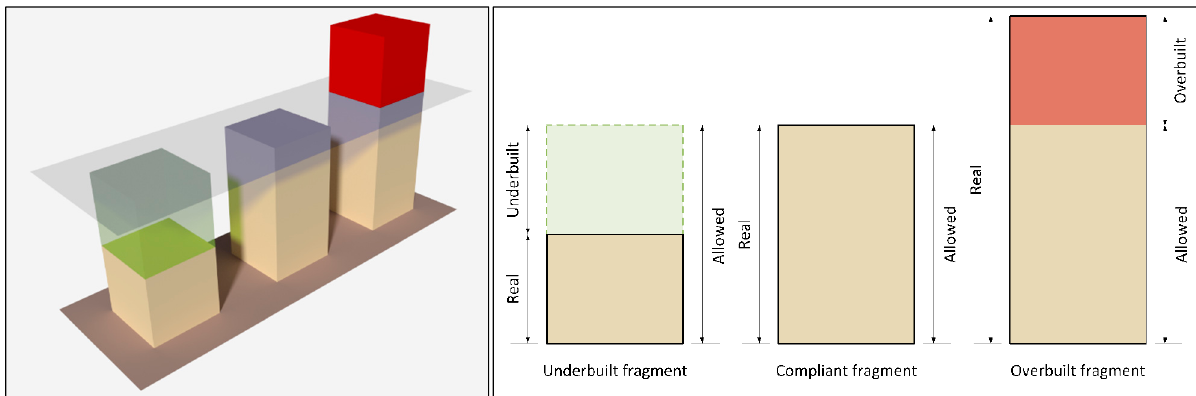
Figure 4. Height interpretation in the 3D